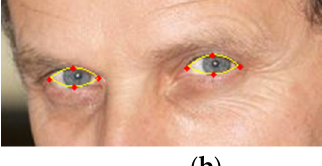
Figure 24: different contact lenses colors are simulated: dark-green, hazel, natural green, and ocean blue respectively.